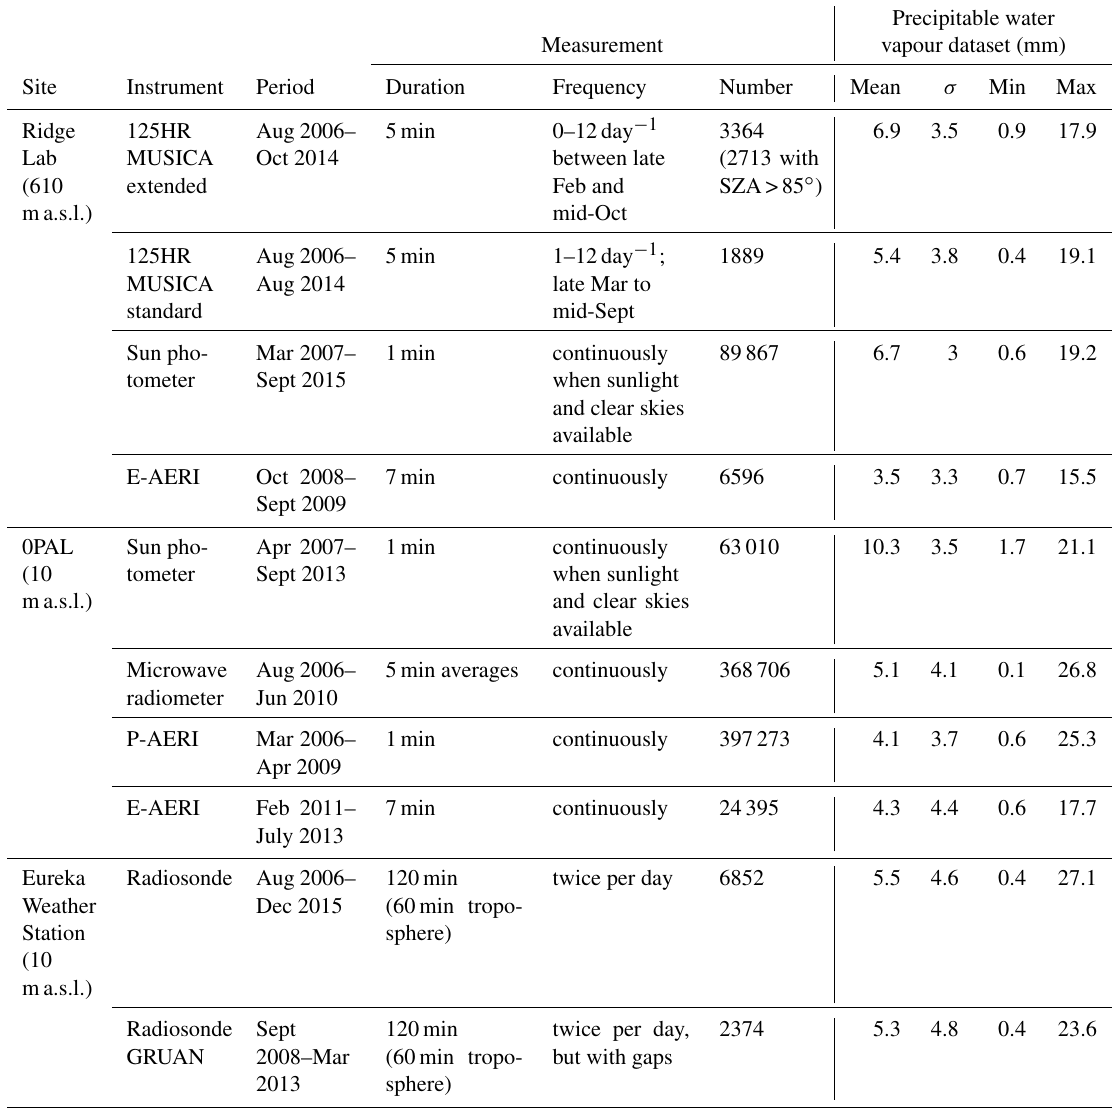
Table 1. Eureka water vapour